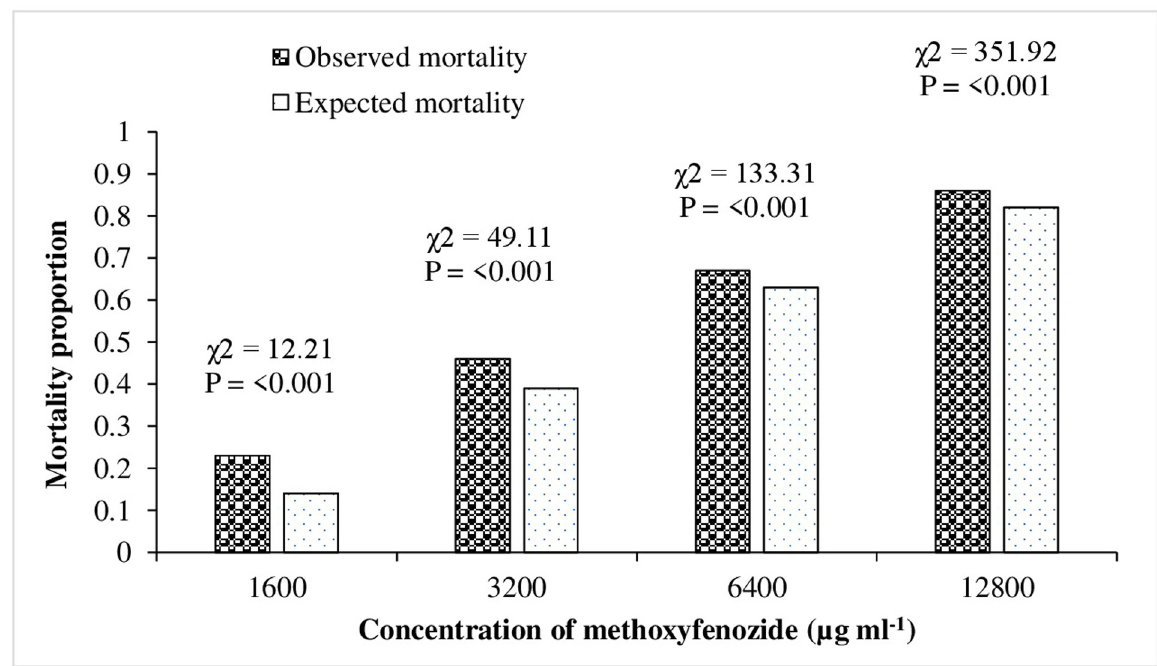
Fig 5. Direct test of monogenic inheritance of resistance to methoxyfenozide by comparing expected and observed mortality of the backcross (F1 ♀ x Susceptible ♂ ) of Chrysoperla carnea .